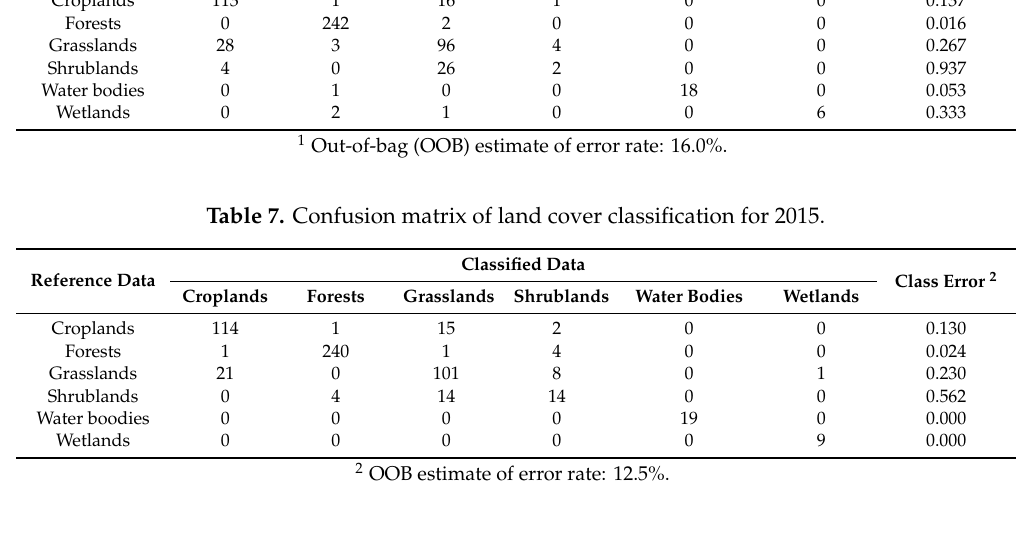
2 OOB estimate of error rate: